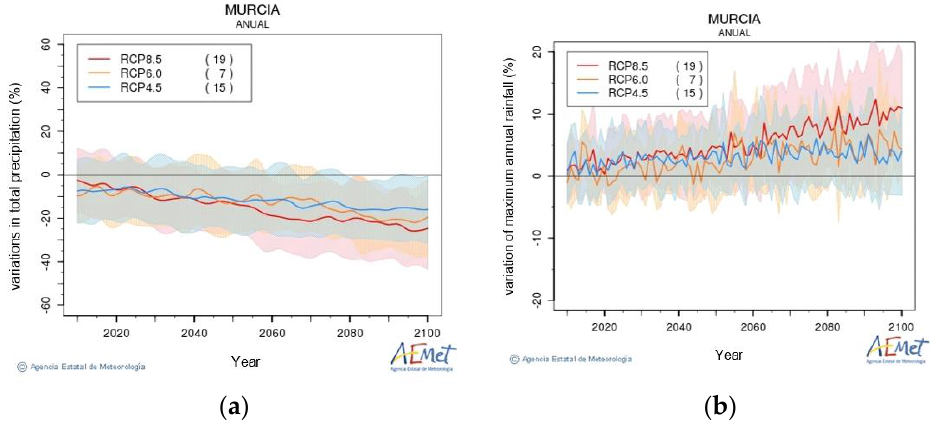
Figure 2 . Climate change scenarios for 2020 – 2100 regarding precipitation in the city of Murcia area using three different Representative Concentration Pathway (RCP) greenhouse scenarios: ( a ) annual rainfall and ( b ) maximum daily rainfall. Source: AEMET [23].